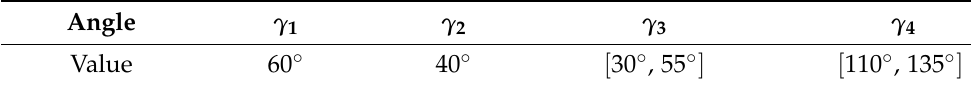
Table 14. Inverse kinematics